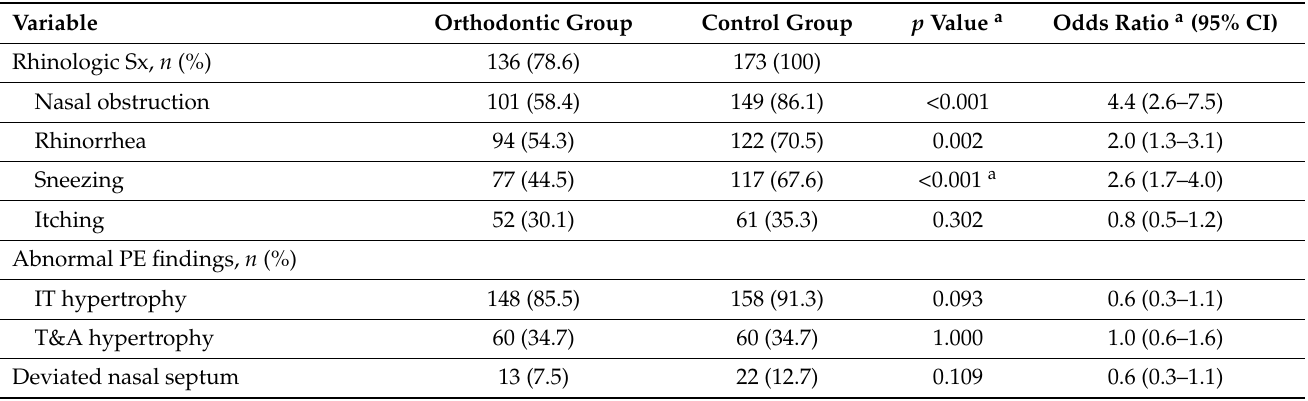
Table 4. Comparison of subjective/objective findings between the skin prick test (+) orthodontic group and the allergic rhinitis (control) group.